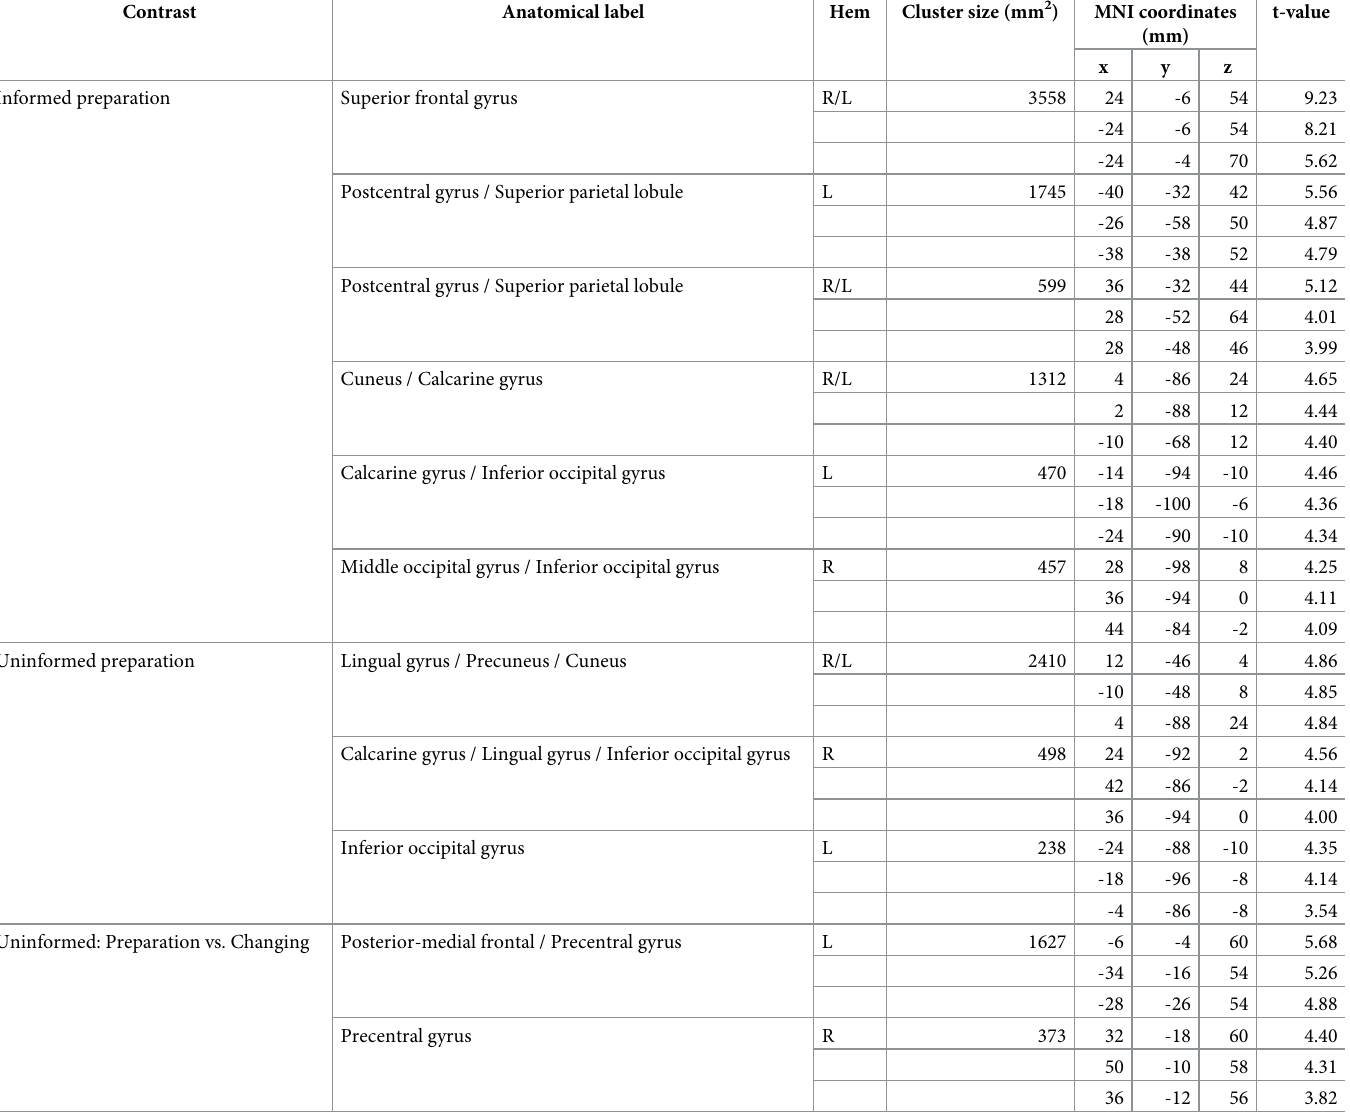
Table 3. Brain regions showing signal increases during the preparation